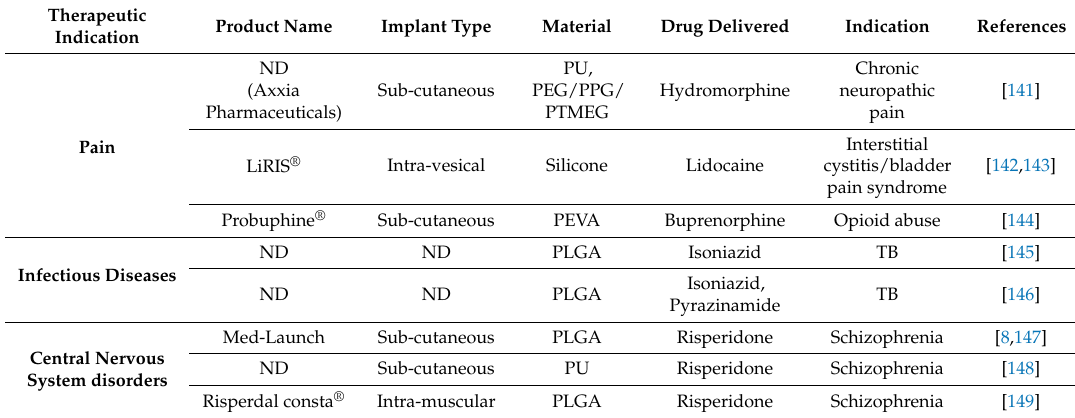
Table 4. Examples of implantable drug delivery devices for pain management, infectious disease and central nervous system disorders. ND = Not